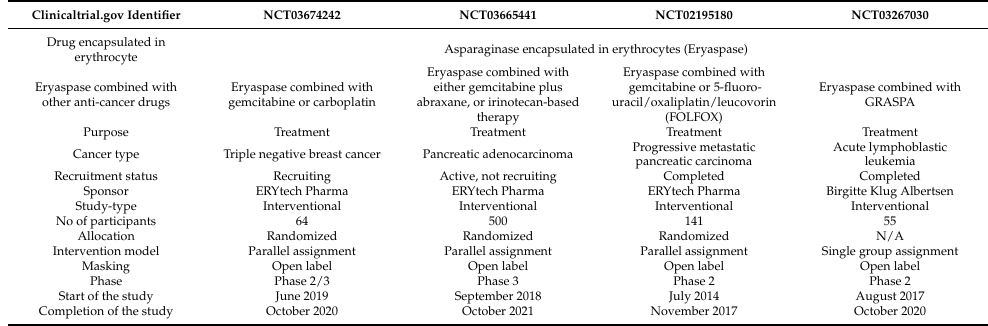
Table 3. List of clinical trials available for asparaginase encapsulated in erythrocytes (Eryaspase).